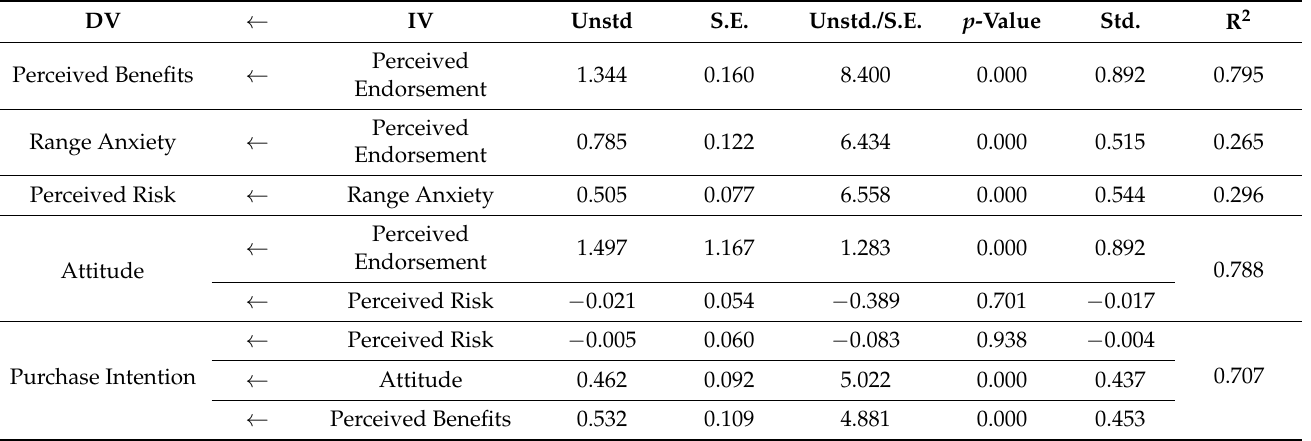
Table 7. Regression